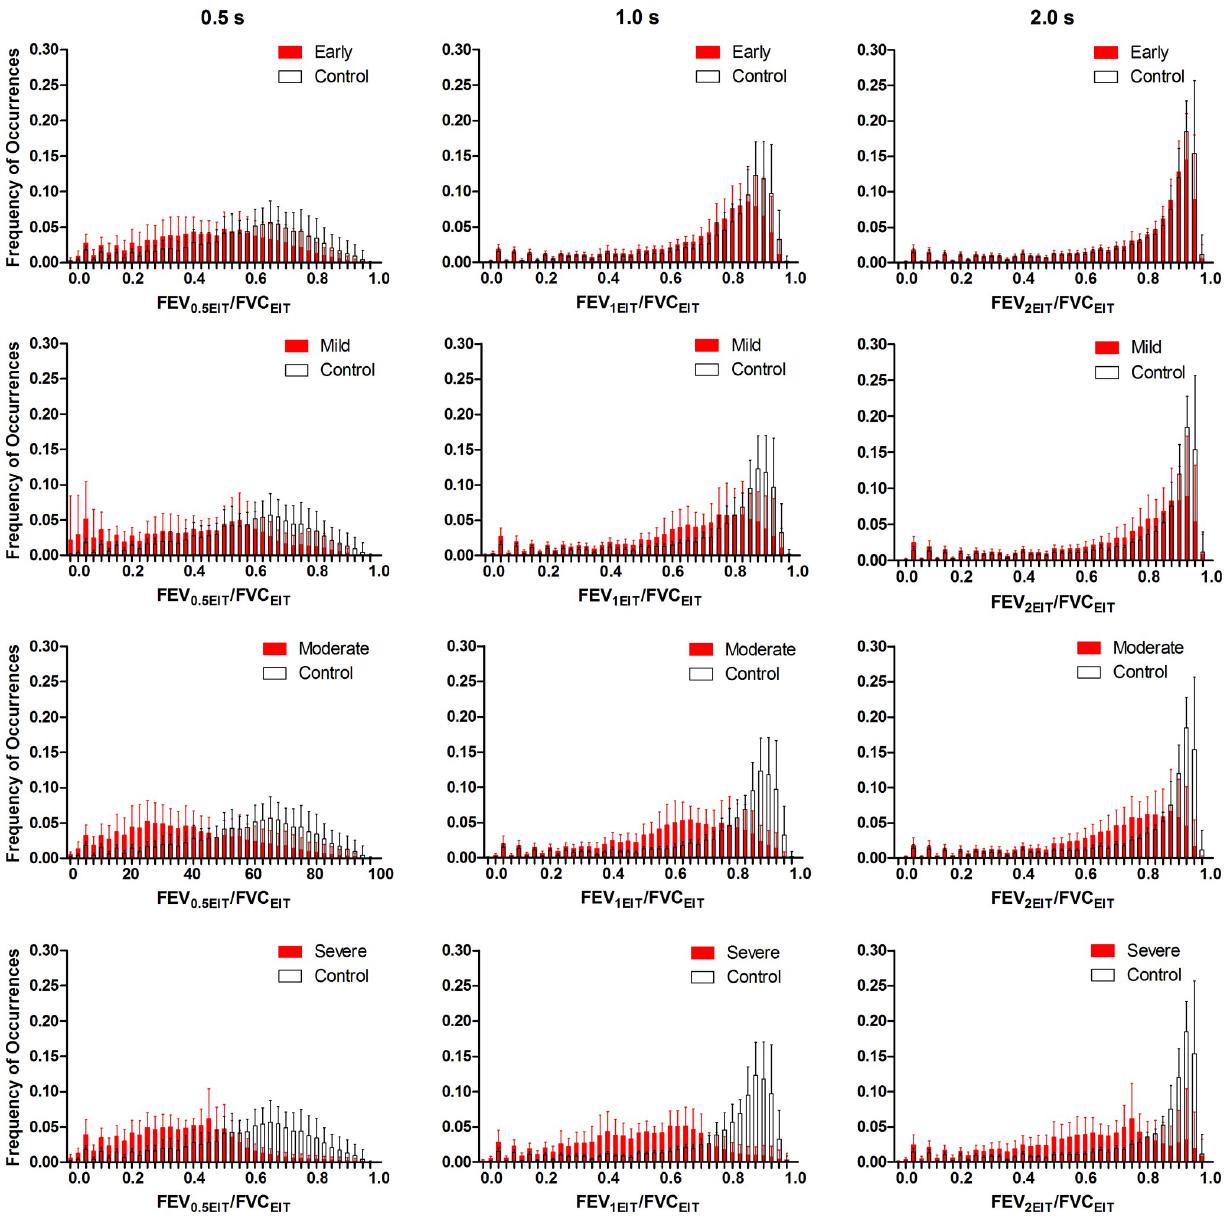
Fig 9. Histograms of pixel FEVt/FVC at different expiratory times. Data are expressed as mean ± SD. Figures show the histograms of FEVt/FVC at 0.5 s (left), 1 s (middle), and 2 s (right) in the groups with different degrees of obstruction (black columns) in comparison with healthy patients in the control group (red columns). FEV1, forced expiratory volume in 1 second; FVC, forced vital capacity.